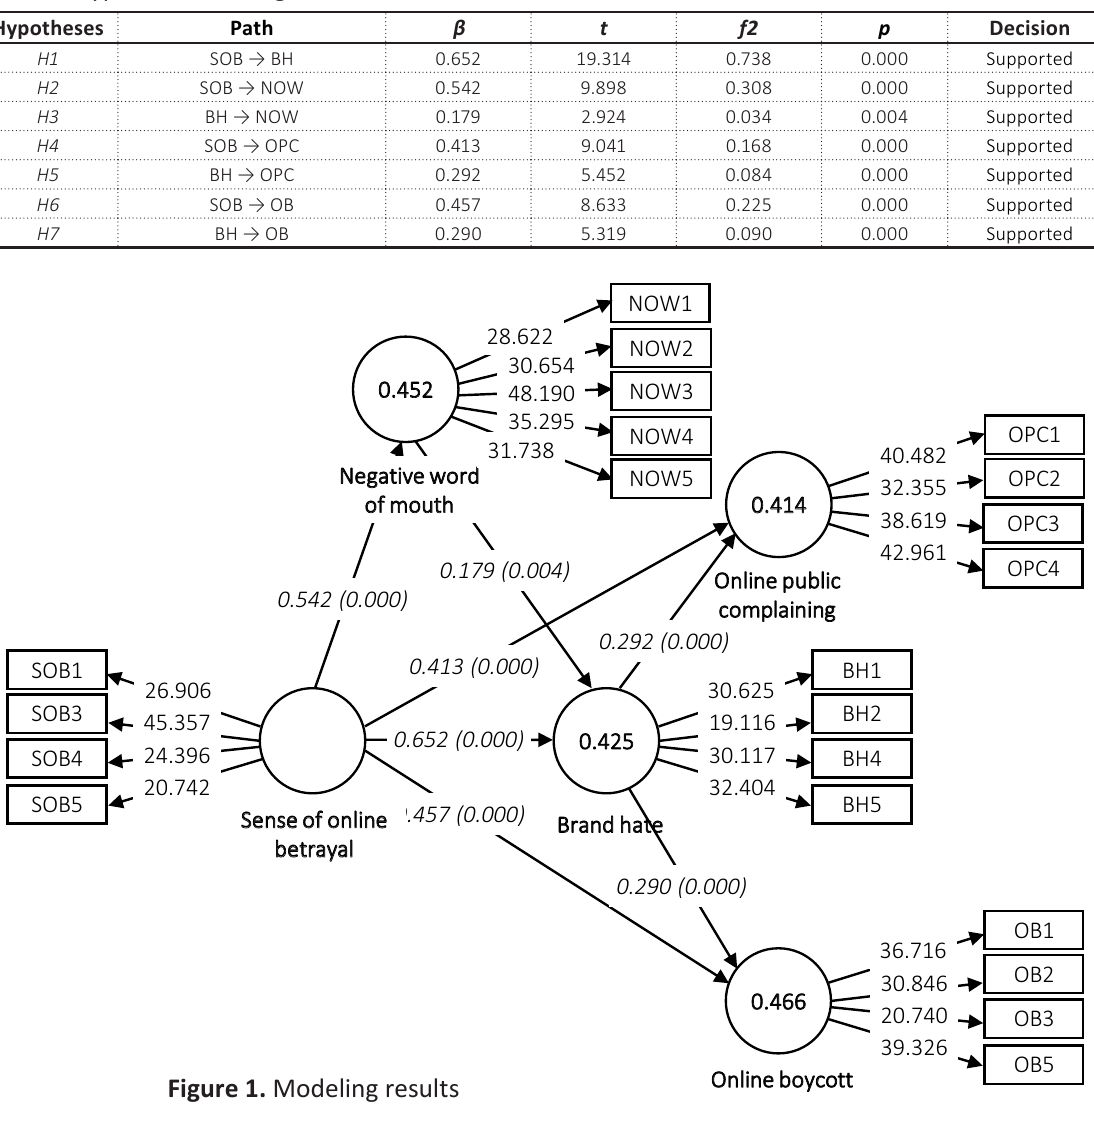
O nline boycott Figure 1. Modeling